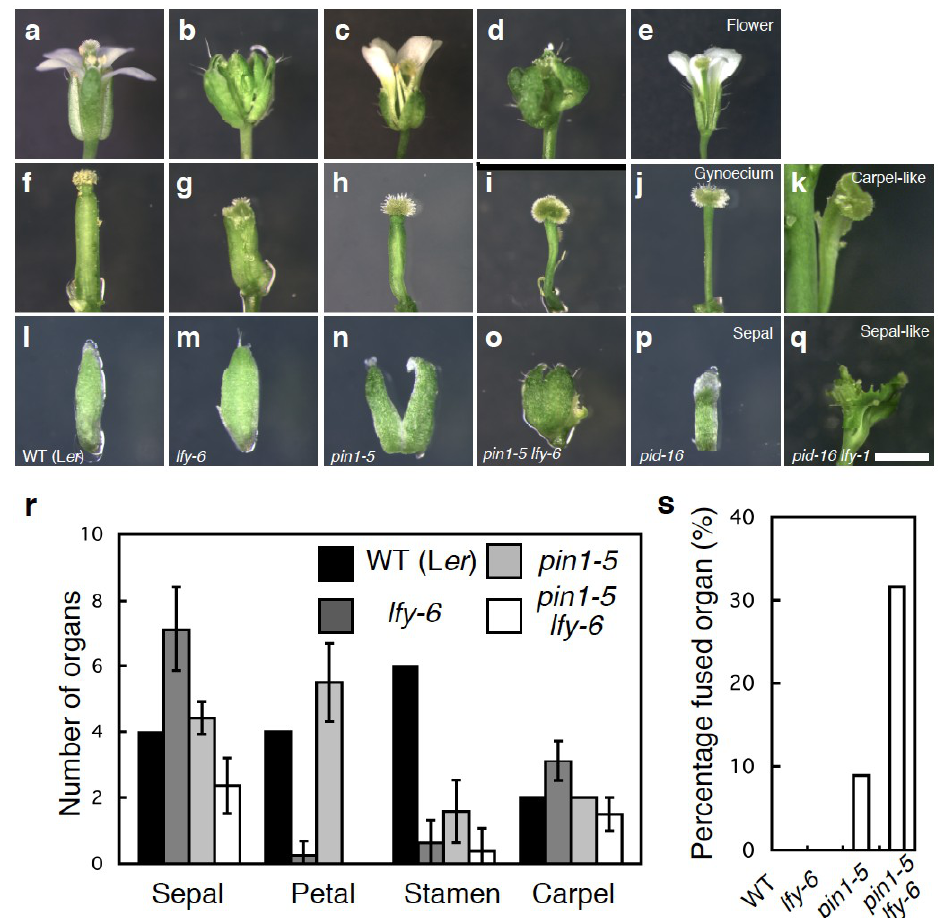
Figure 2. lfy enhances the flower developmental defects of auxin transport mutants. ( a – e ) Side view of the flowers formed in wild type ( a ), lfy-6 ( b ), pin1-5 ( c ), pin1-5 lfy-6 ( d ), pid-16 ( e ); ( f – k ) Side view of the gynoecium formed in wild type ( f ), lfy-6 ( g ), pin1-5 ( h ), pin1-5 lfy-6 ( i ), pid-16 ( j ), pid-16 lfy-1 ( k ); ( l – q ) Side view of the sepal formed in wild type ( l ), lfy-6 ( m ), pin1-5 ( n ), pin1-5 lfy-6 ( o ), pid-16 ( p ), pid-16 lfy-1 ( q ); ( r ) Floral organ number in wild-type, lfy-6 , pin1-5 , and lfy-6 pin1-5 flowers; ( s ) Incidence of sepal fusion in wild-type, lfy-6 , pin1-5 , and lfy-6 pin1-5 flowers. Scale bar, 2